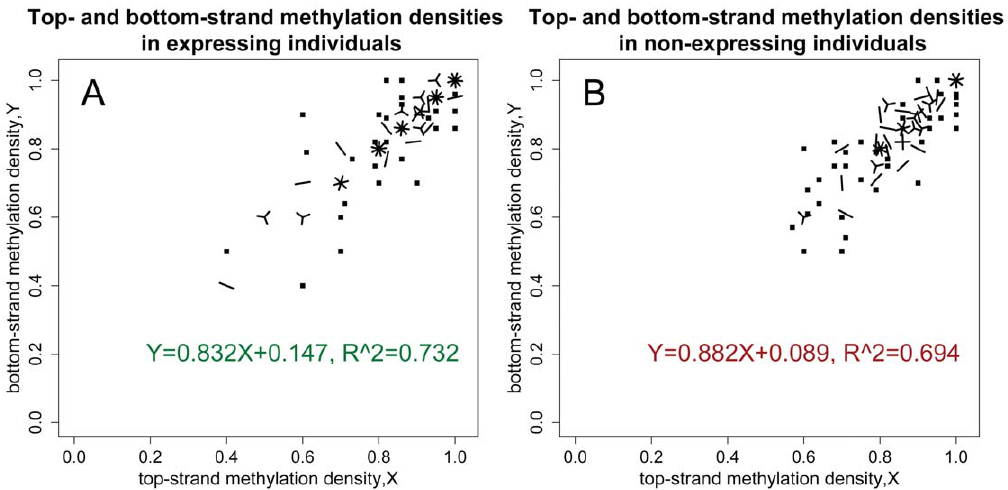
Figure 5. Assessment of methylation mosaicism between the two strands of individual DNA molecules in samples from males with fragile X syndrome. Data are presented separately for samples from FMR1 mRNA-expressing males (A), and from non-expressing males (B). Weighted linear regression was used to account for differences in the numbers of CpG sites captured by the three different hairpins. The different icons of this ‘‘sunflower’’ plot reflect the number of observed epialleles with a given density of methylation on the top and bottom strands. A single epiallele is represented as a dot, two epialleles with identical methylation densities as a line, three epialleles as a ‘‘three-petal’’ flower, and so on up to the maximum in our data set of nine molecules.